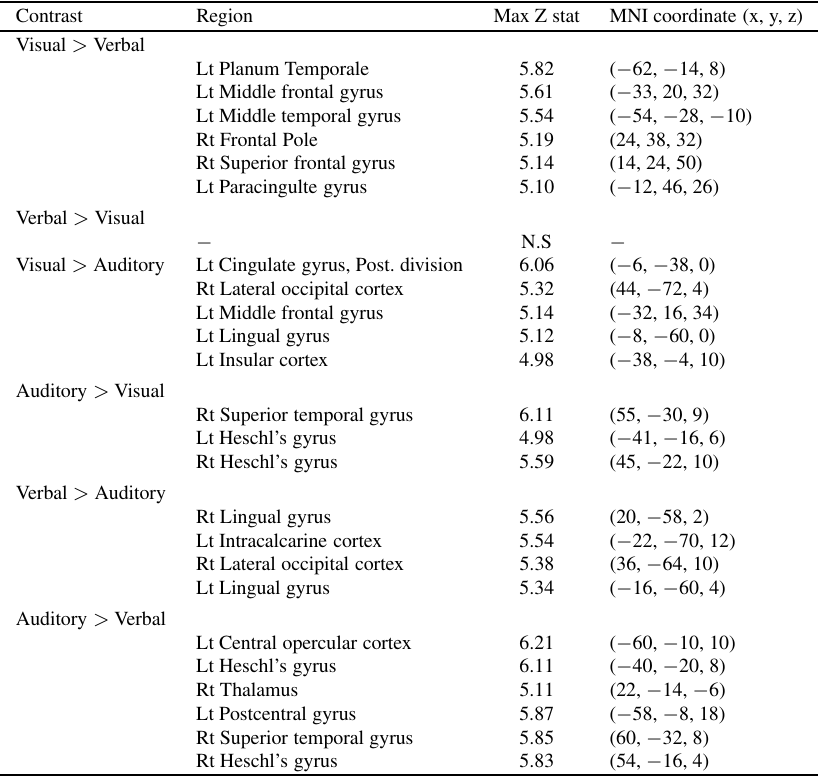
Table 2 Comparison of activations between the tasks; regardless of